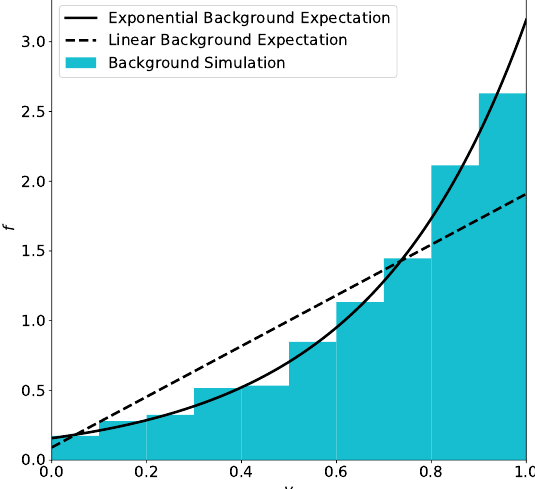
Figure 34 . The unit-normalized background distribution (A.3) (solid line) and the corresponding simulated data (histogram) used for the example considered in section A.2. For comparison, the dashed line shows the linear background distribution used for the example in section A.1.